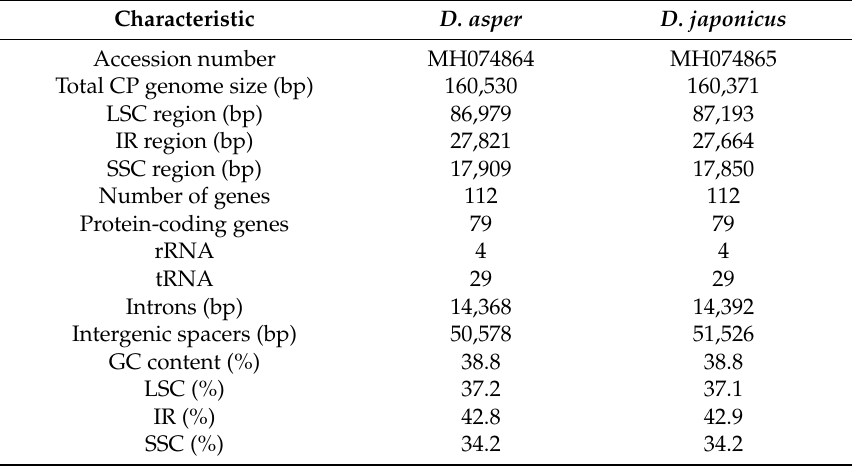
Table 2. The characteristics of the chloroplast (CP) genomes of D. asper and D. japonicus . Characteristic D.